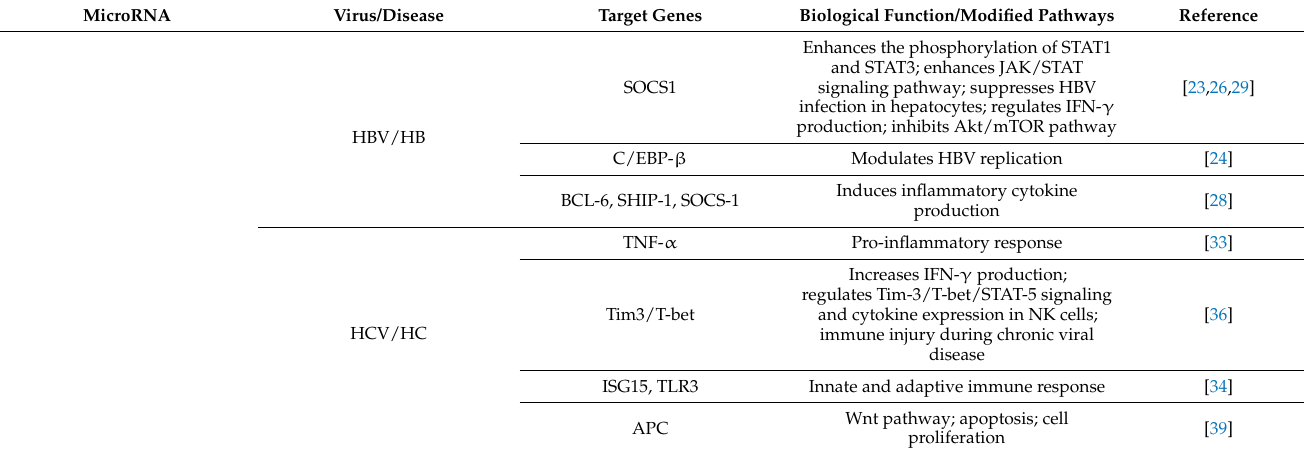
Table 1. MicroRNAs important in human viral